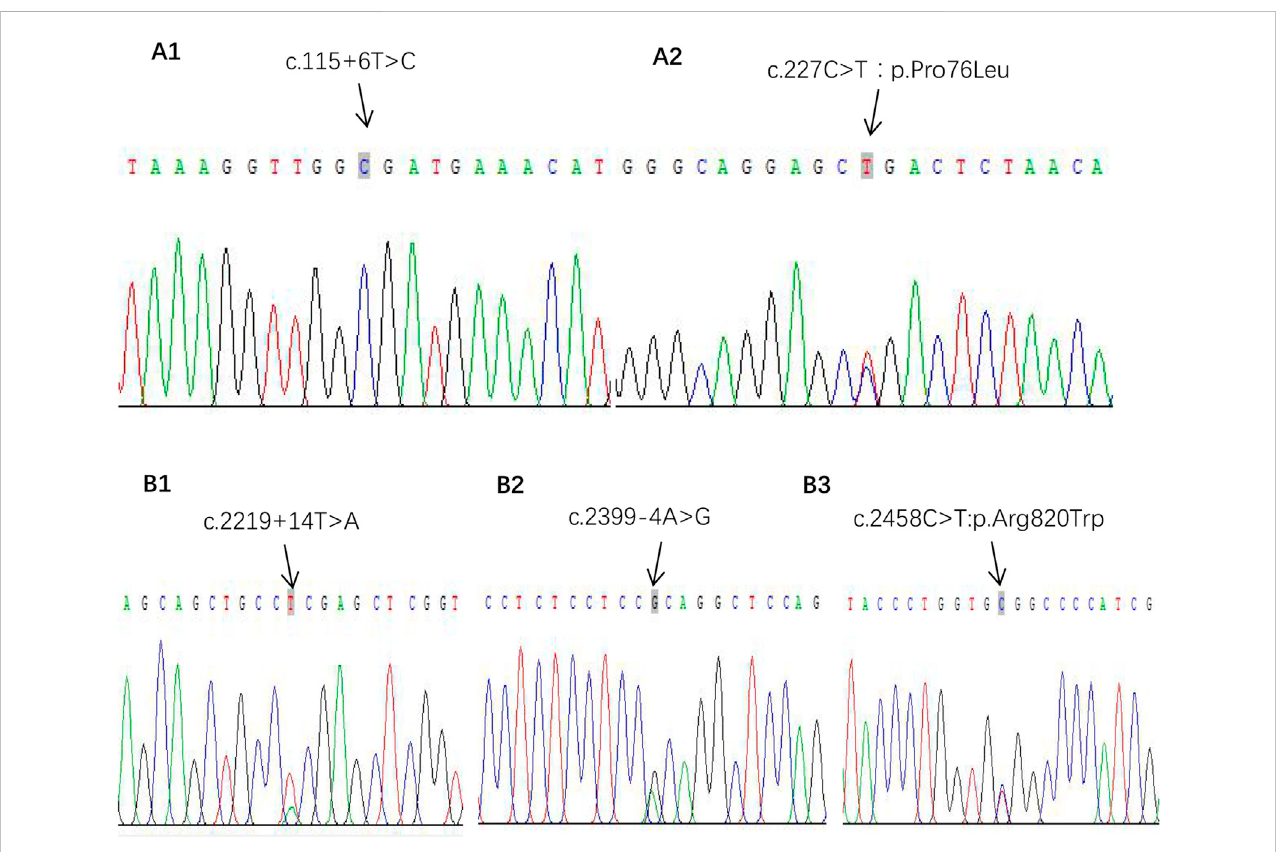
FIGURE 3 Gene mutations of IPP. (A1, A2) Gene IL-36RN pathogenic mutation sites. (B1 – B3) Gene CARD14 heterozygous mutation